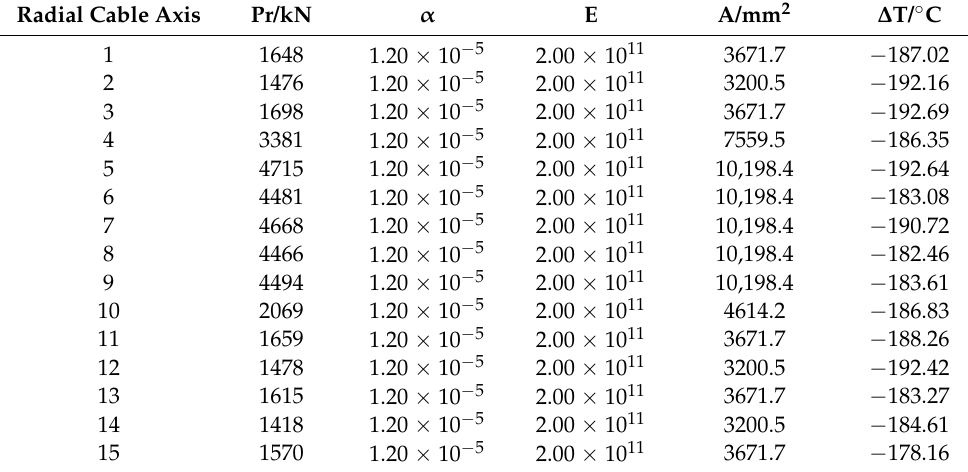
Table 5. Equivalent temperature difference of 1/4 radial